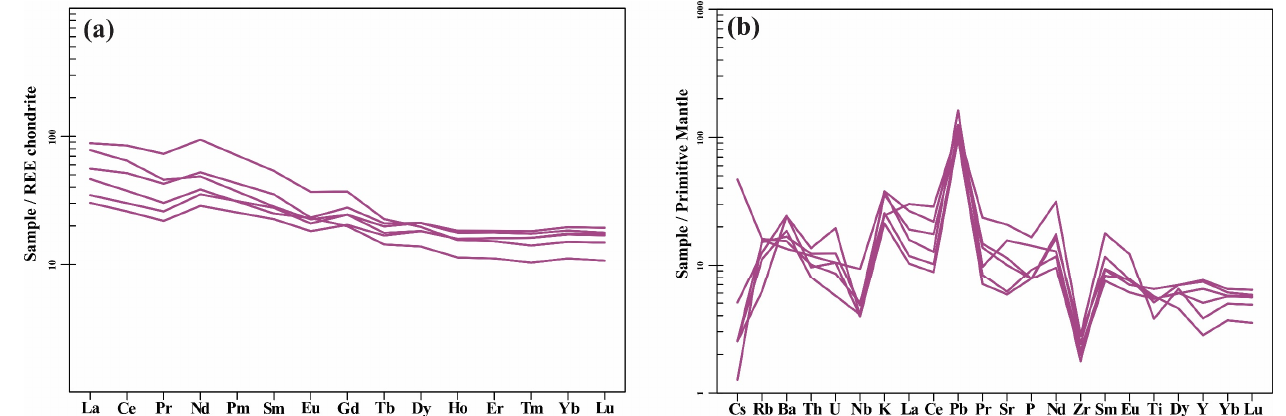
Figure 6. ( a ) Chondrite-normalised REE diagram of gabbros; ( b ) primitive-mantle-normalised trace element diagrams of gabbros.